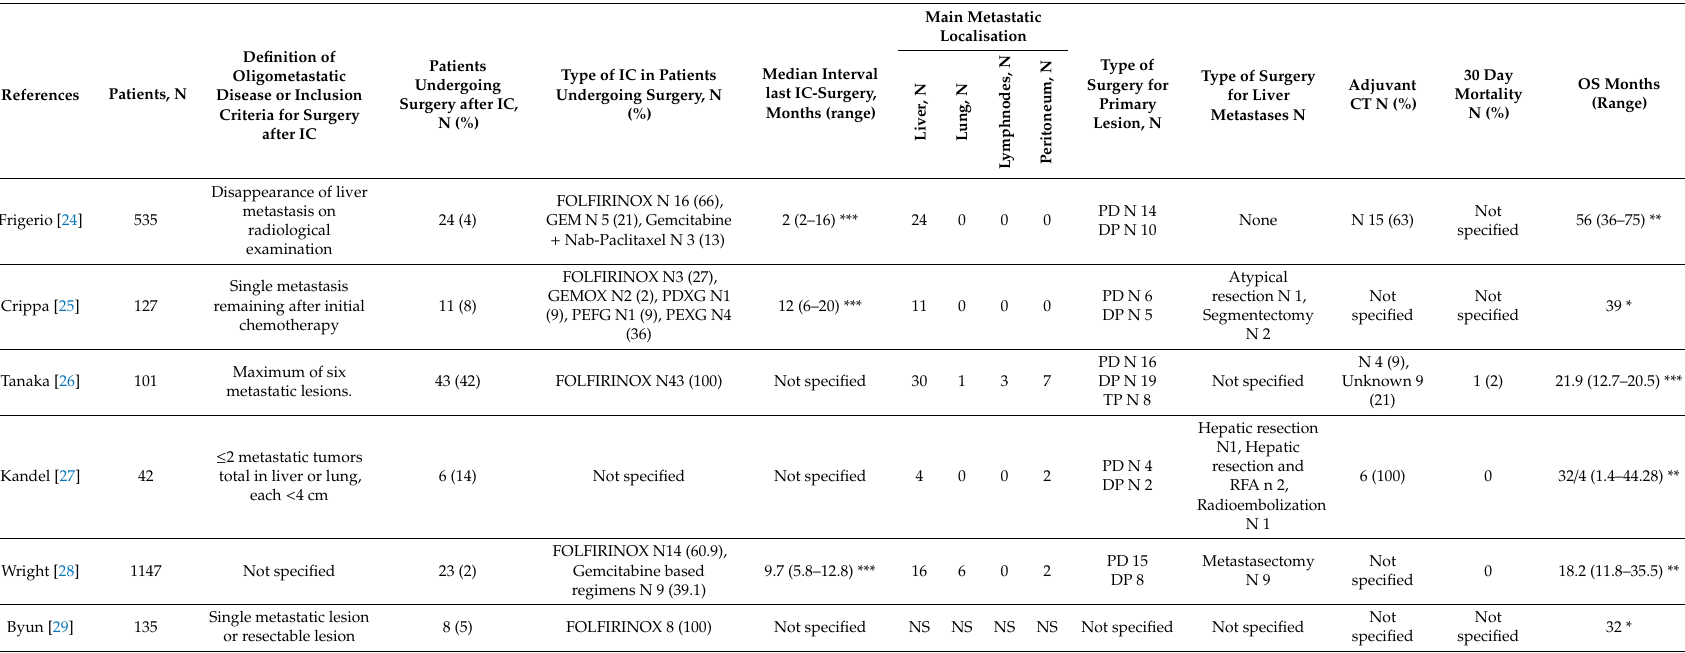
Table 3. Characteristics of patients with mPDAC undergoing surgery after initial